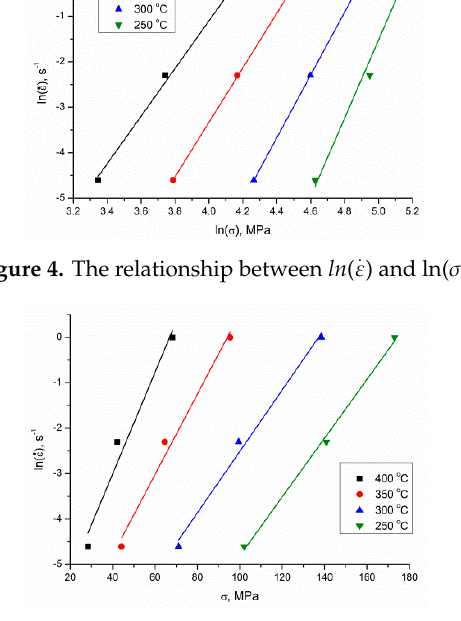
Figure 5. The relationship between ln( 𝜀(cid:4662) ) and σ .